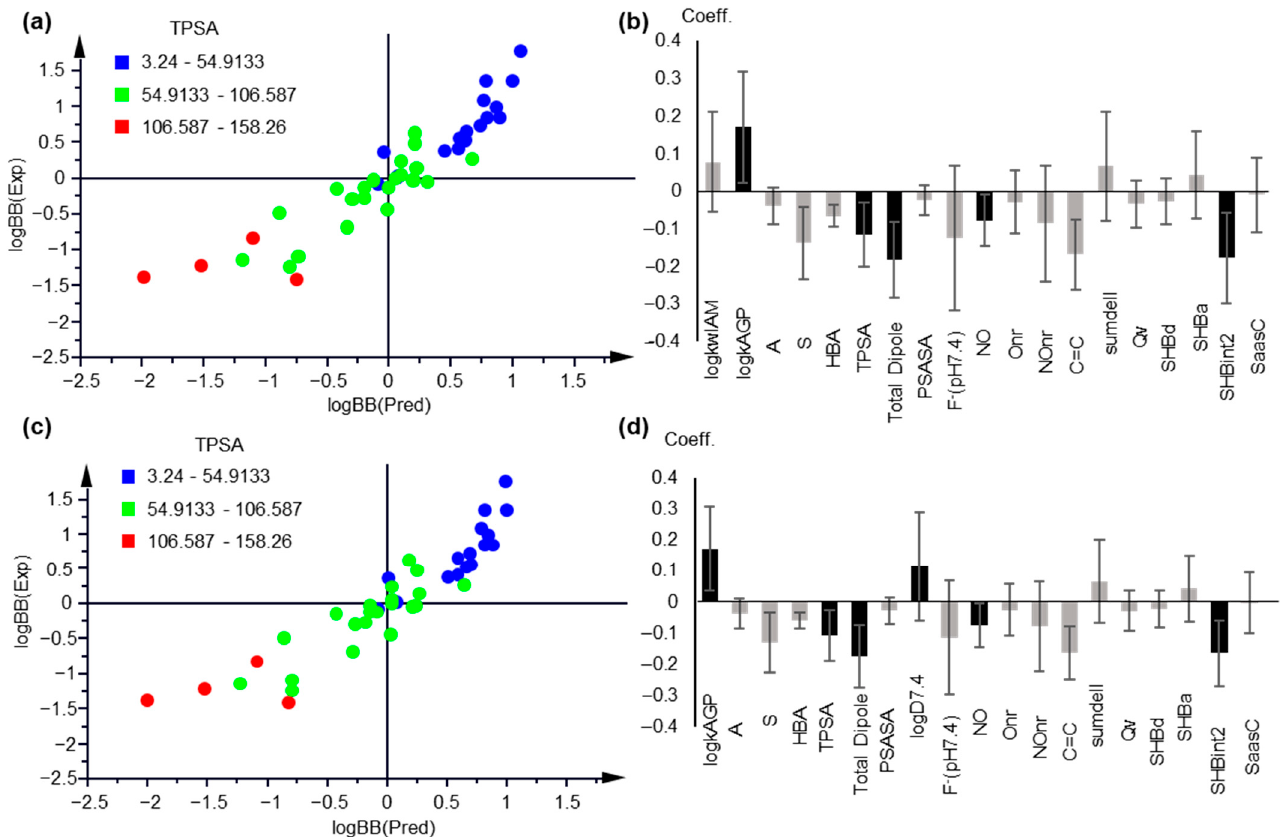
Figure 4. PLS modeling of logBB based on chromatographic and lipophilicity data. ( a ) Observed vs. predicted logBB values plot, based on PLS Model 5; ( b ) Coefficient plot of the original variables of PLS Model 5; ( c ) Observed vs. predicted logBB values plot, based on PLS Model 6; ( d ) Coefficient plot of the original variables of PLS Model 6. In ( a , c ), the compounds are colored based on their TPSA values. In ( b , d ), variables with VIP > 1 are highlighted with black.